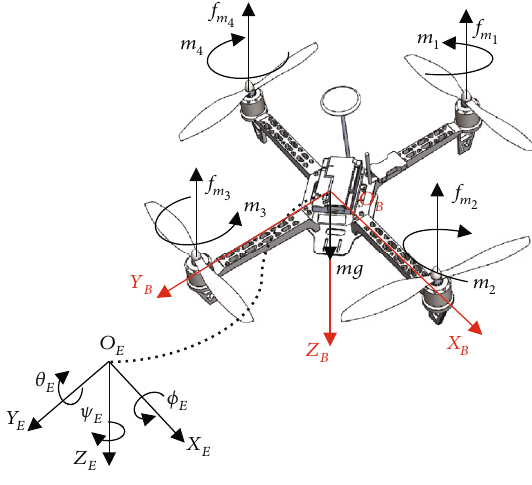
Figure 1: The con fi guration of the